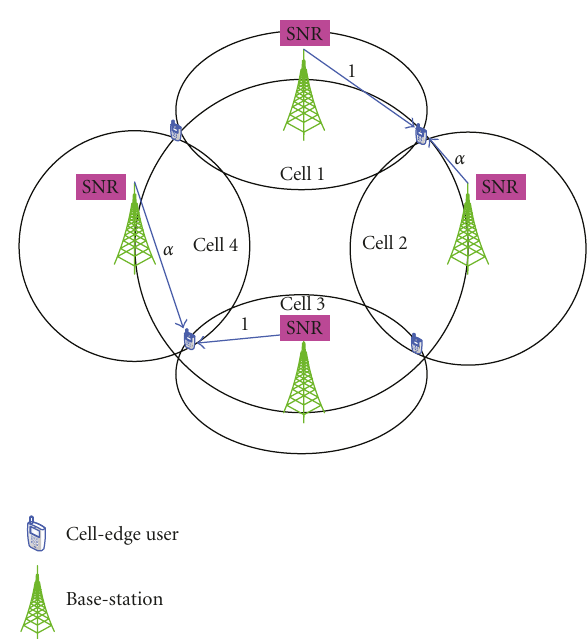
Figure 4: Inter-cell cophasing with reuse, combined with intra-cell